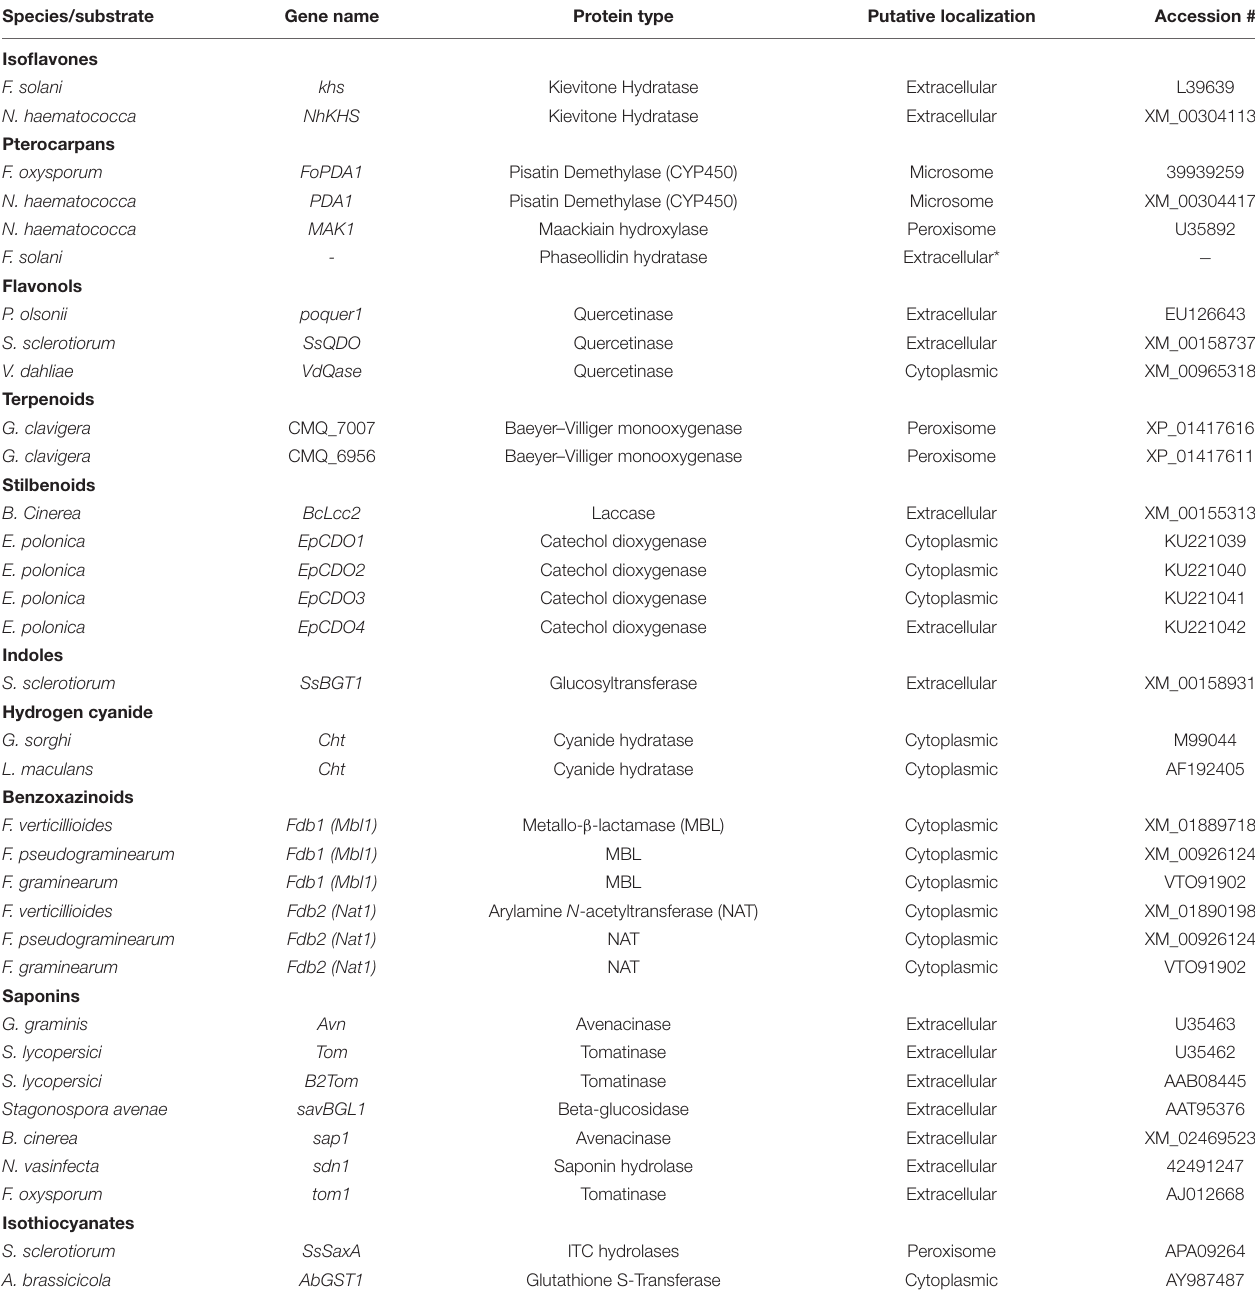
TABLE 2 | Characterized genes encoding detoxification enzymes from fungal